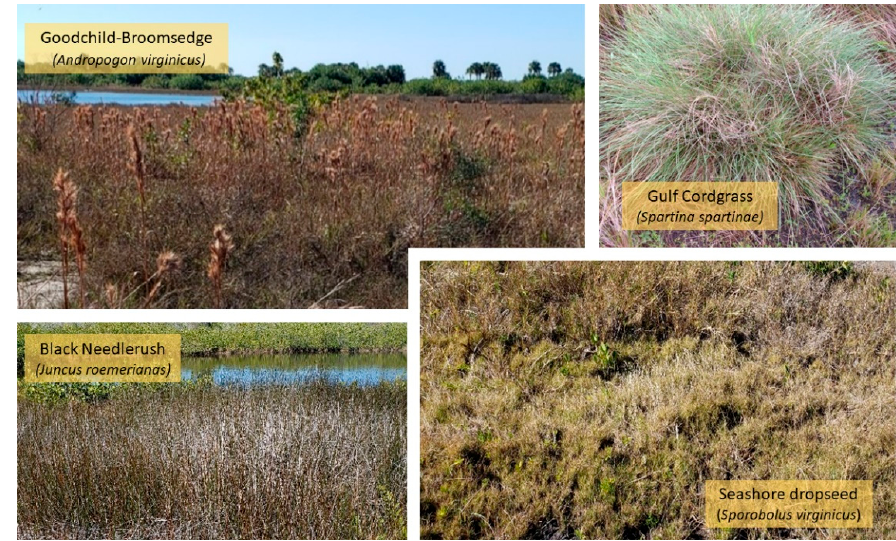
Figure 4. Native grass species naturally occurring as well as used in coastal restoration.